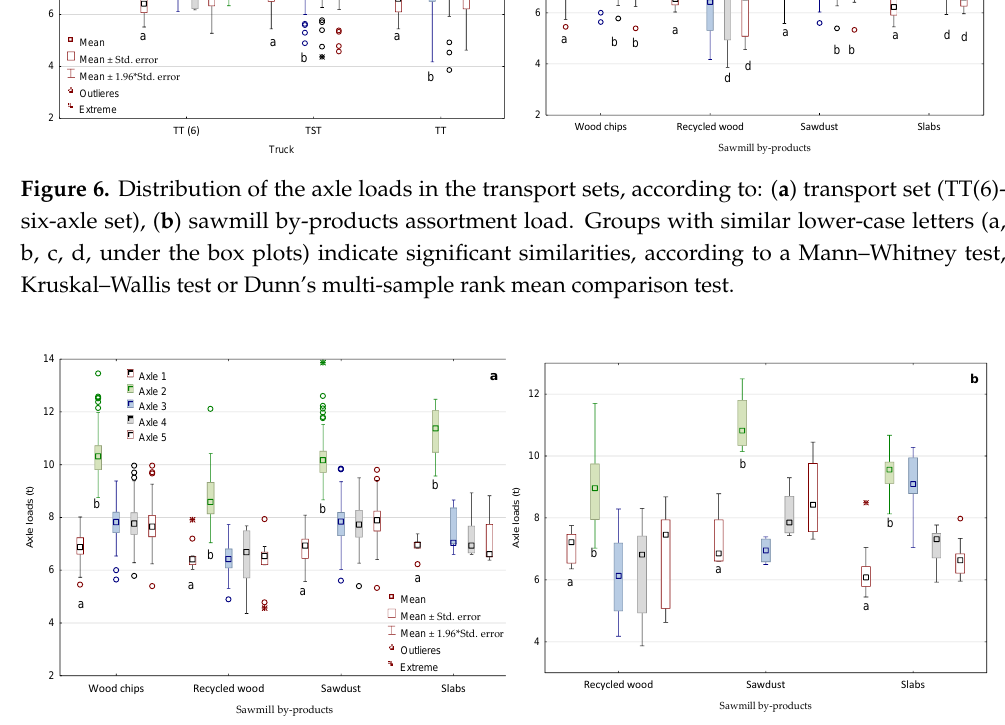
Figure 7. Axle load in five-axle sets, depending on the sawmill by-product assortments: ( a ) track and semi-trailer, ( b ) truck and trailer. Groups with similar lower-case letters (a, b, c, d, under the box plots) indicate significant similarities, according to a Kruskal–Wallis test or Dunn’s multi-sample rank mean comparison test.